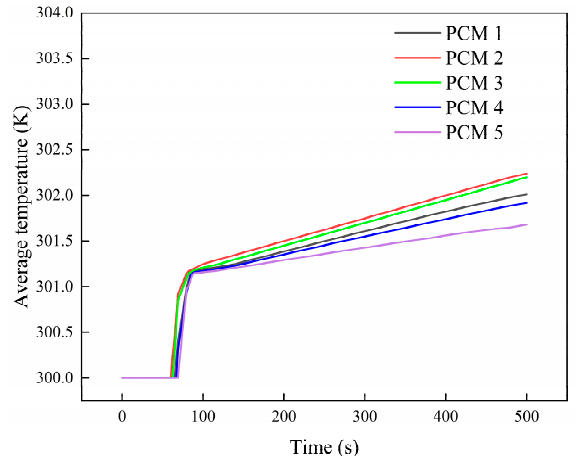
Figure 16. The average temperature change in the PCM in different regions when the No. 2 battery is thermally runaway.